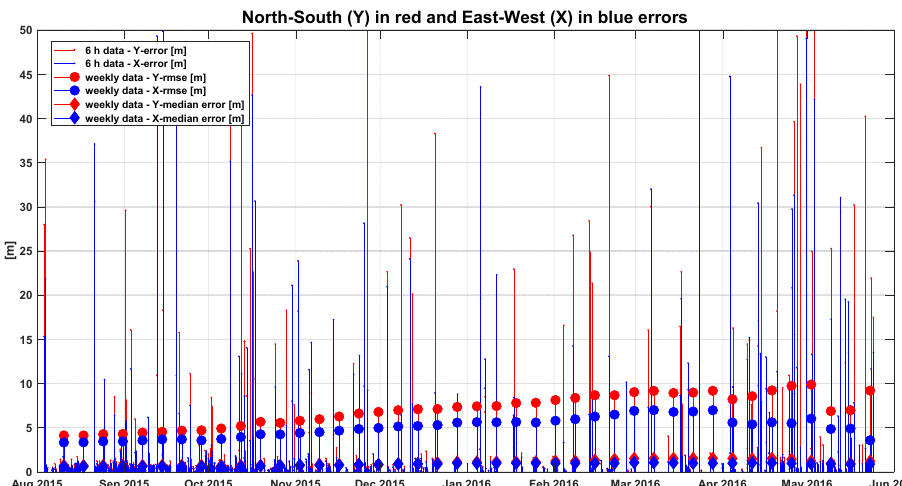
Figure 17. Evolution of the 6-h position error (stem plot), the weekly root man squared errors (circles), and the median errors (diamonds) in north-south (Y-component, in red) and east-west (X-component, in blue). Six instances with errors larger than 50 m rmse were found.